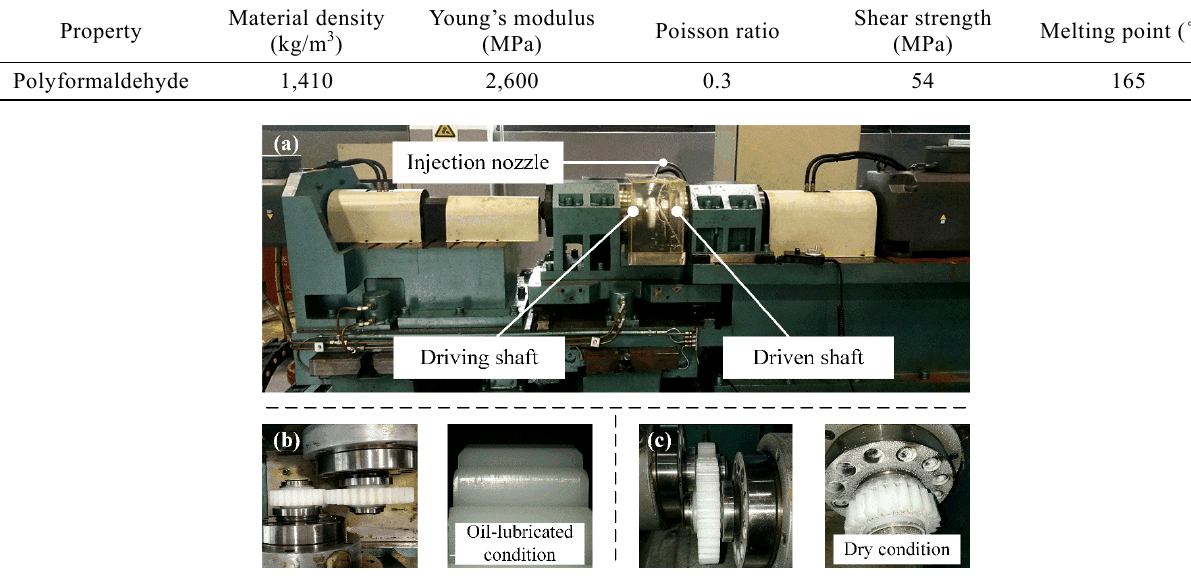
Fig. 2 Gear durability test rig.